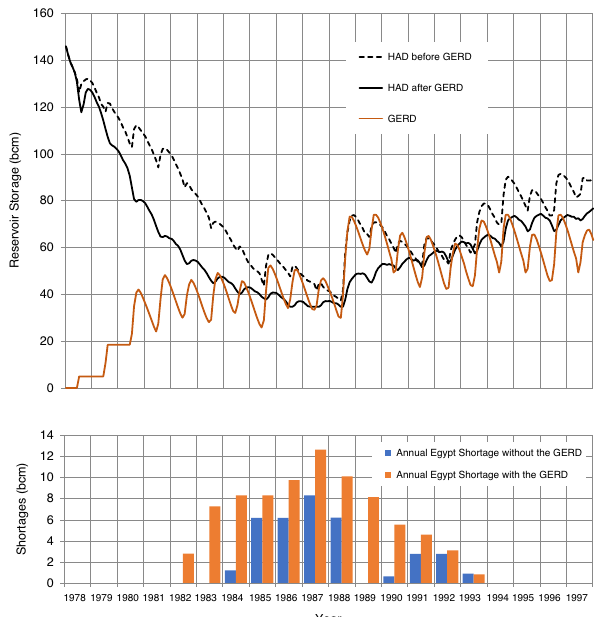
Fig. 5 GERD fi lling effects during a historically dry 10-year sequence followed by a recovery period. Storage volumes for the GERD and HAD are shown above and shortages to Egyptian planned releases are shown below.